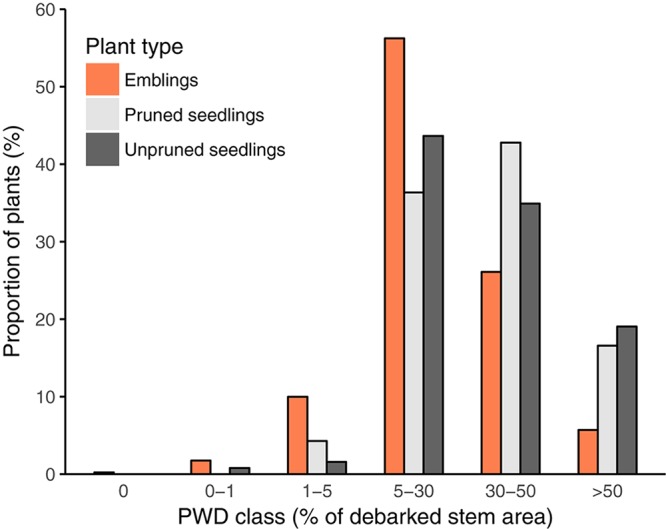
Proportions of plants in each of the six Pine Weevil Damage classes (PWD class, Table 2) used to record levels of damage for all plants (emblings, pruned, and unpruned seedlings) in trial A. Extent of damage in each class is expressed as a range of minimum and maximum values of percentage of debarked stem area.